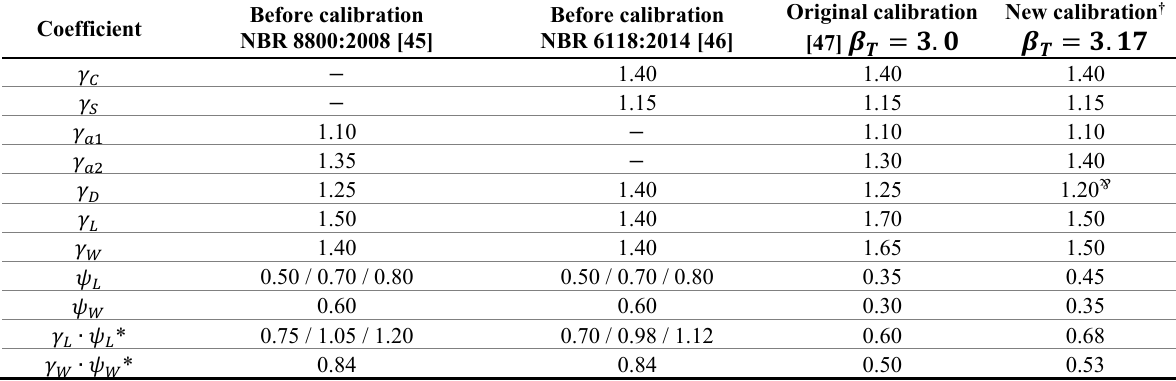
Table 5. Updated partial safety factors, following the procedure of [47] with new live load statistics.